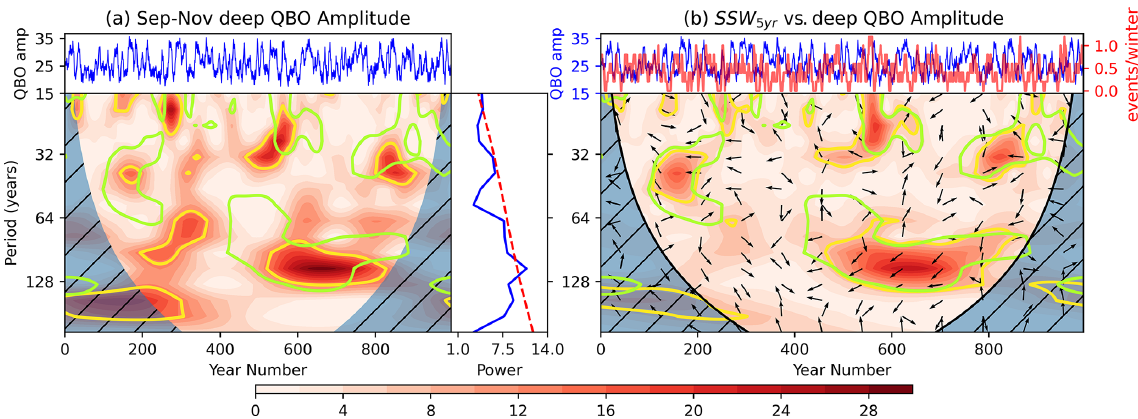
Figure 12. As Fig. 8 for the September–November deep QBO (15–30hPa) amplitude index smoothed with a 5-year window. (a) QBO amplitude time series and associated wavelet power spectrum. (b) Cross-power spectrum between deep QBO amplitude and SSW 5 years .